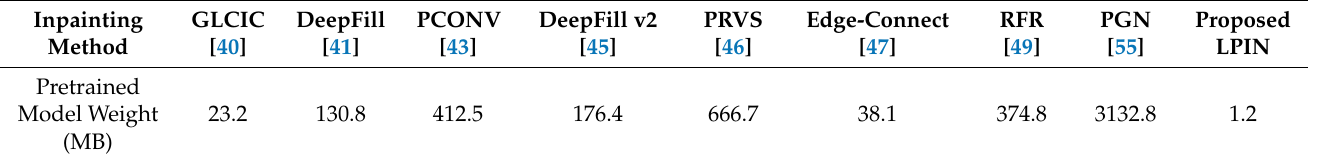
Table 1. The size of pretrained model weight of different inpainting